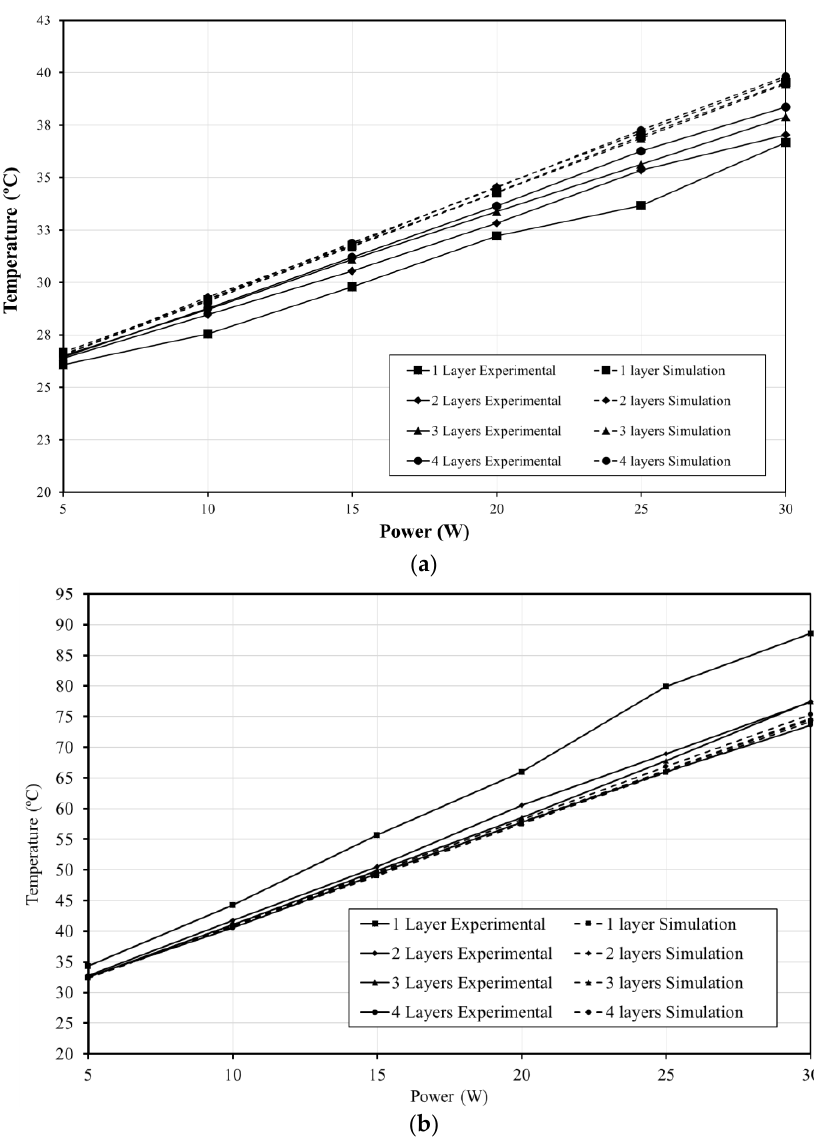
Figure 7. Validation of simulation results compared with experimental data for 30 mL/min water flow rates for layers ranged from one to four for ( a ) the temperature of the heat source in the middle top surface; ( b ) HTF outlet temperature versus the power.